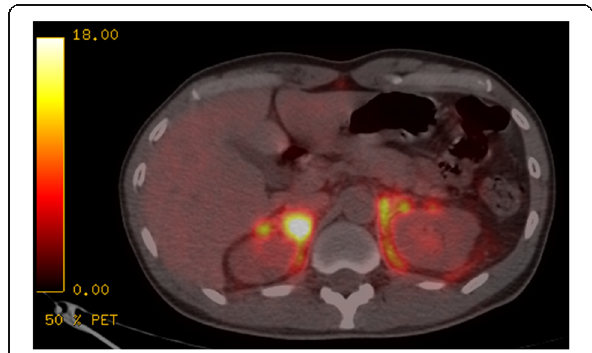
Fig. 1 The iodine-123-metaiodobenzylguanidine (MIBG) scintigraphy image. MIBG scintigraphy showed increased uptake of MIBG in both adrenal glands, which was consistent with the diagnosis of bilateral pheochromocytomas